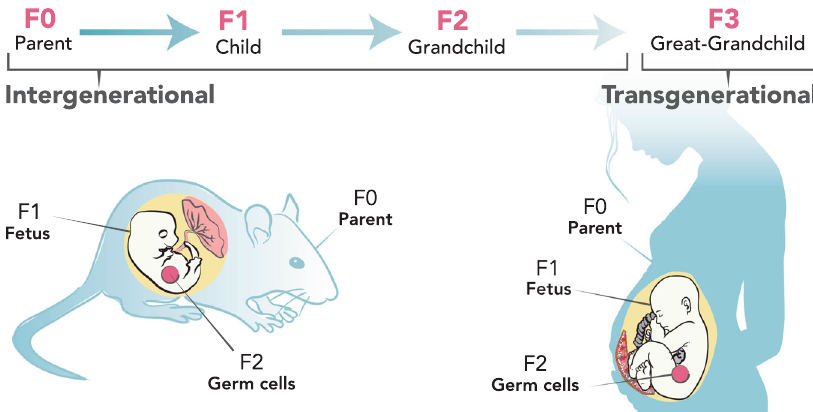
Fig. 1 Intergenerational and transgenerational inheritance. Depiction of inheritance patterns from the parent (F0) generation to the child (F1), grandchild (F2), and great-grandchild (F3) in humans and animals. An exposure in F0 can directly affect the developing fetus (F1) and the germ cells in F2; therefore, both routes of transmission are considered intergenerational. Transgenerational effects may be observed beginning with the F3